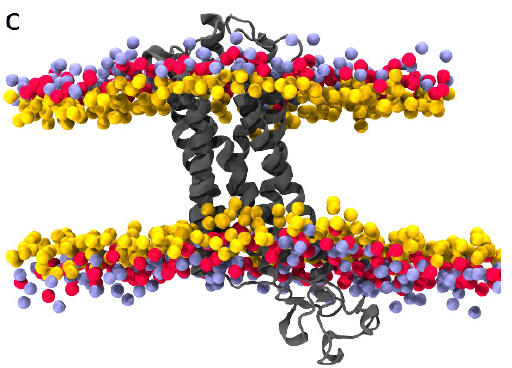
Figure 3. Therapeutic targets associated with CVD. ( a ) Adenosine A2A receptor (PDB ID: 2YDV) [242]. ( b ) P2Y1 receptor (PDB ID:4XNV) [243]. ( c ) Thromboxane receptor TxA2 (PDB ID: 6IIU) [244].